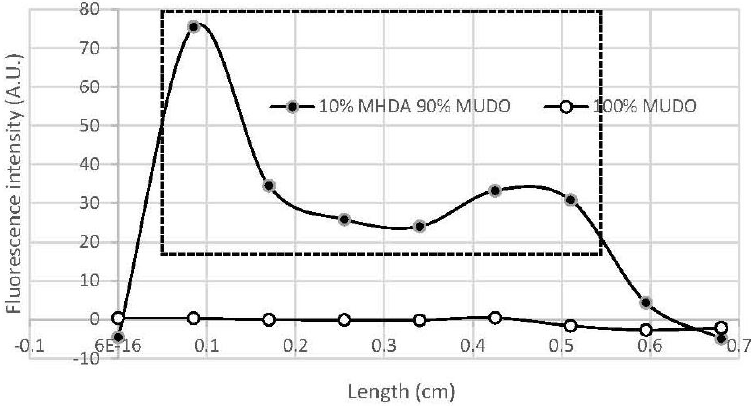
Figure 1. GaAs functionalized surfaces after incubation with Cy5-NHS fluorophore. GaAs